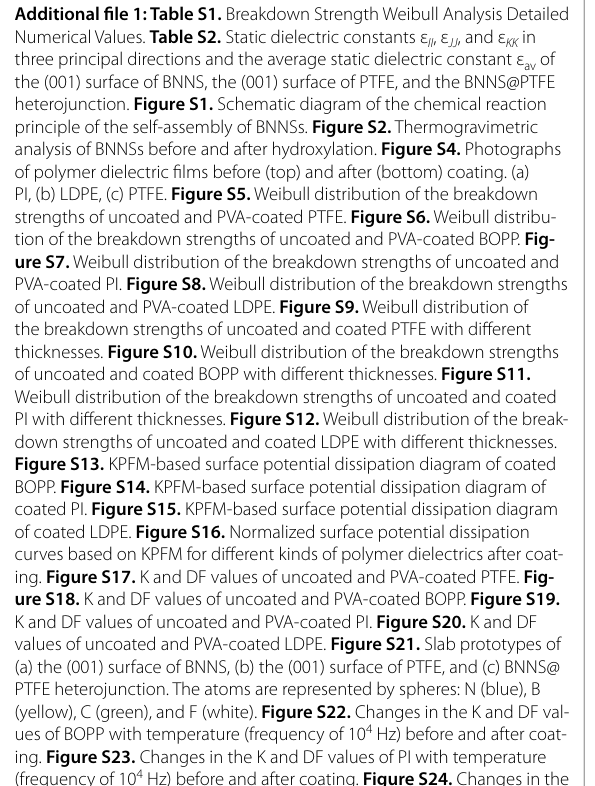
Figure S13. KPFM‑based surface potential dissipation diagram of coated BOPP. Figure S14. KPFM‑based surface potential dissipation diagram of coated PI. Figure S15. KPFM‑based surface potential dissipation diagram of coated LDPE. Figure S16. Normalized surface potential dissipation curves based on KPFM for different kinds of polymer dielectrics after coat‑ ing. Figure S17. K and DF values of uncoated and PVA‑coated PTFE.